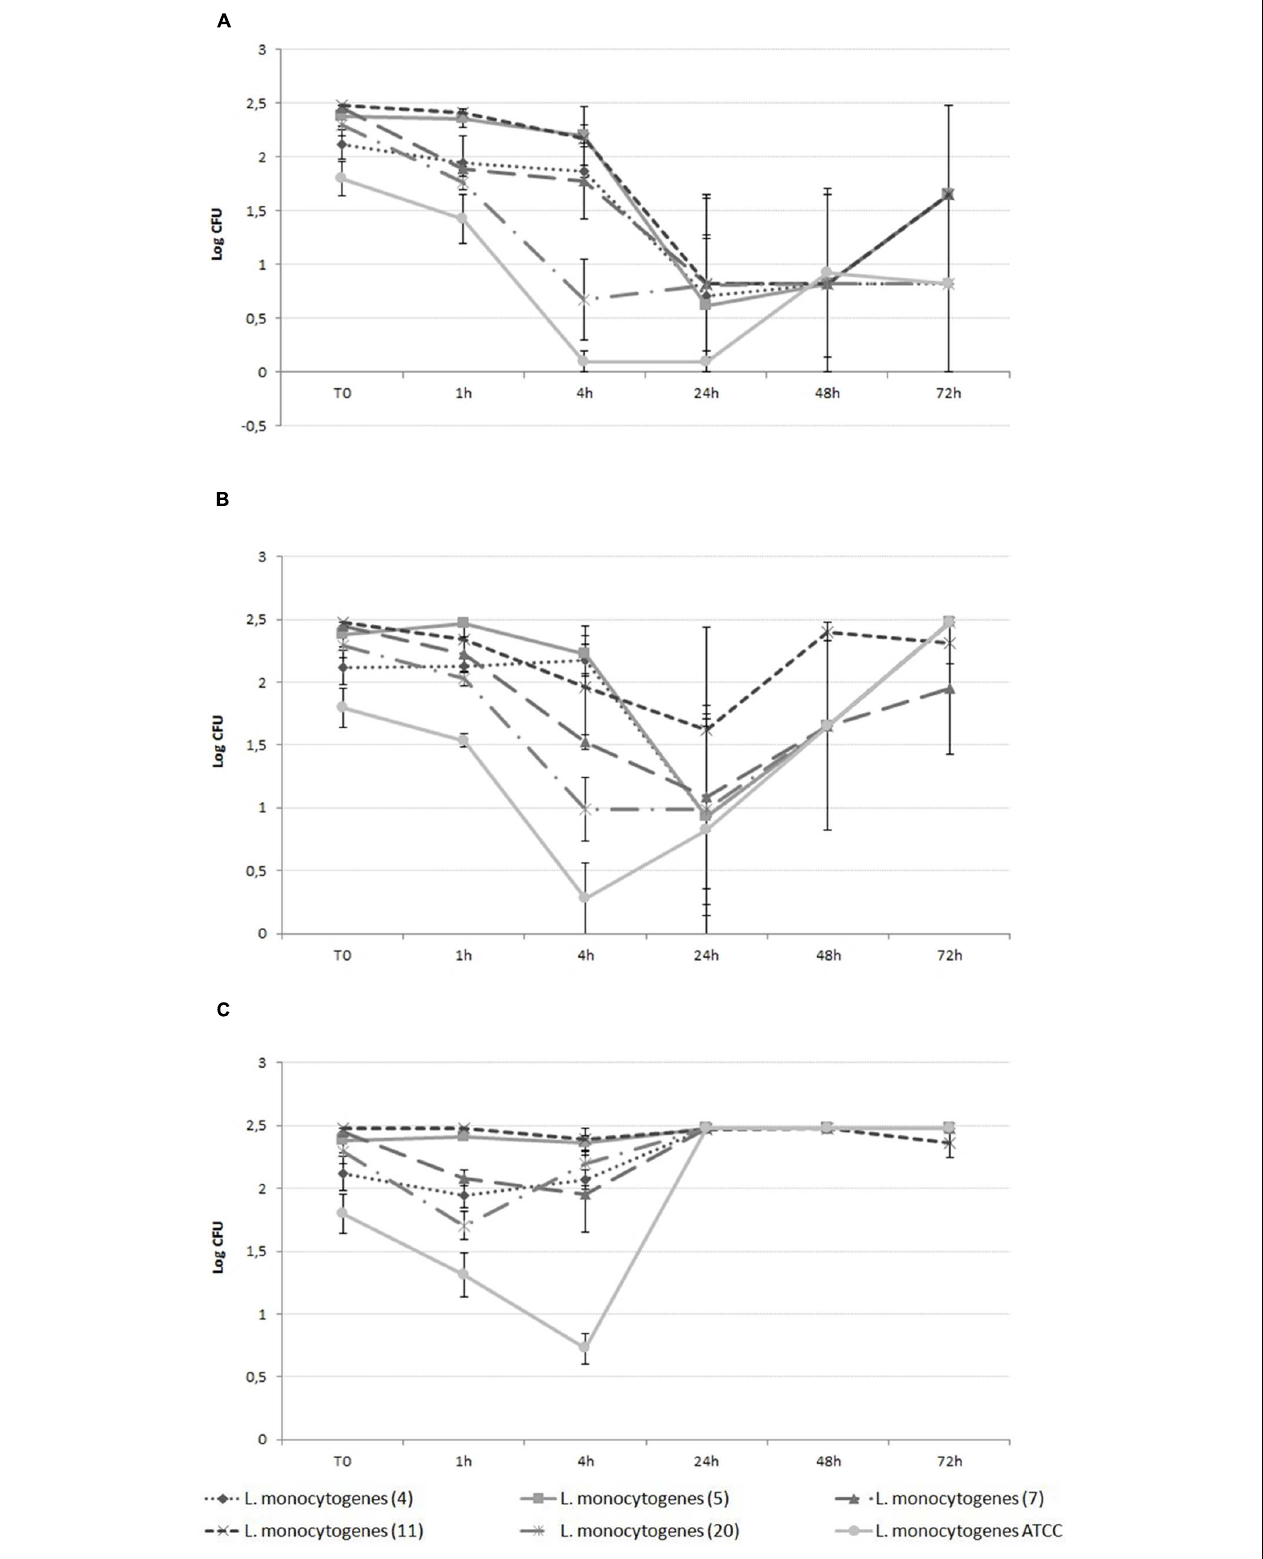
FIGURE 2 | Growth curve of L. monocytogenes in the presence of 30 ppm (A), 20 ppm (B), and 10 ppm (C) AgNO 3 .